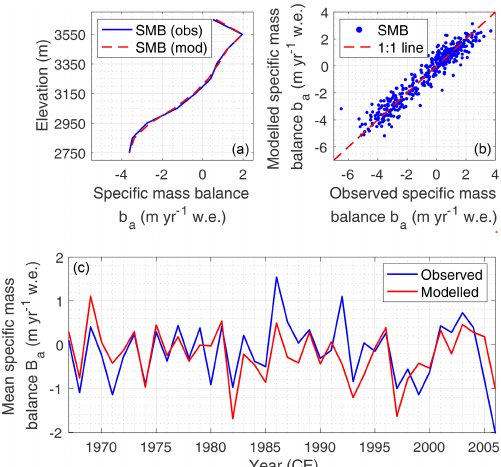
Figure 4. Calibrated mass balance model of the Djankuat Glacier for fixed geometry, showing the observed and modelled (a) mass balance–elevation profile for the 1967/68–2006/07 period, (b) local annual surface mass balances b a for the 1967/68–2006/07 period, and (c) modelled and observed mean specific mass balance B a since the start of the monitoring period. Observed mass balance data are retrieved from Popovnin and Naruse (2005) and WGMS